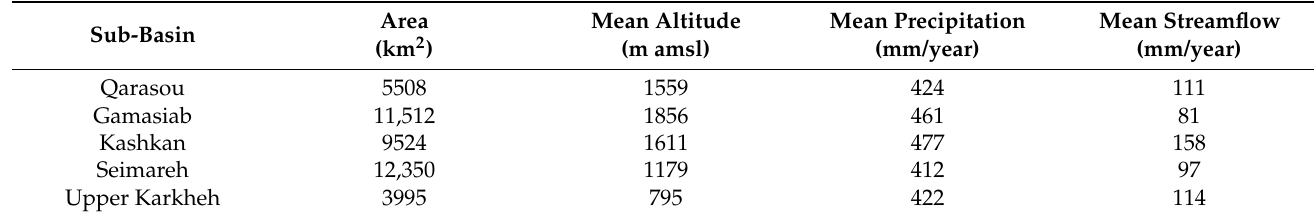
Table 1. Karkheh sub-basin